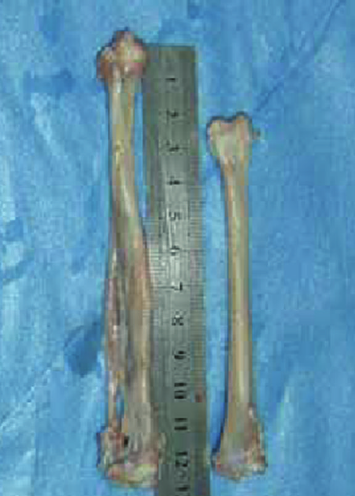
Figure 2: Compared with uninjured lateral tibia (right), operation side lateral tibia (left) extended 2 cm.